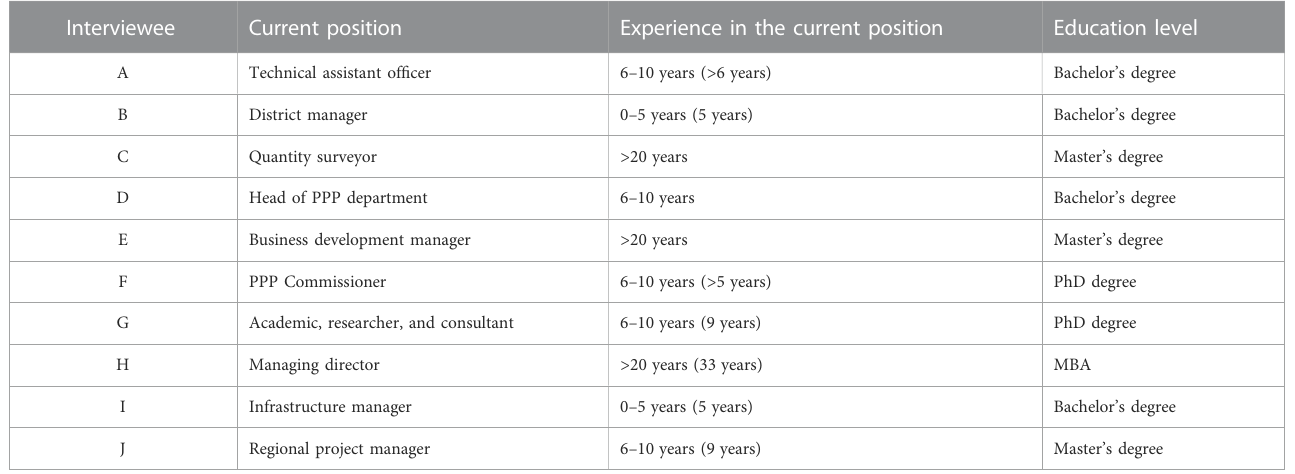
TABLE 1 Pro fi le of interviewees- individual